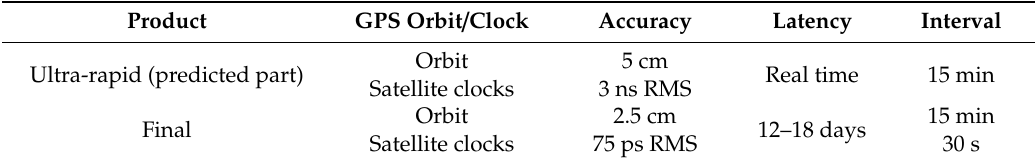
Table 1. International GNSS Service (IGS) ultra-rapid and final products